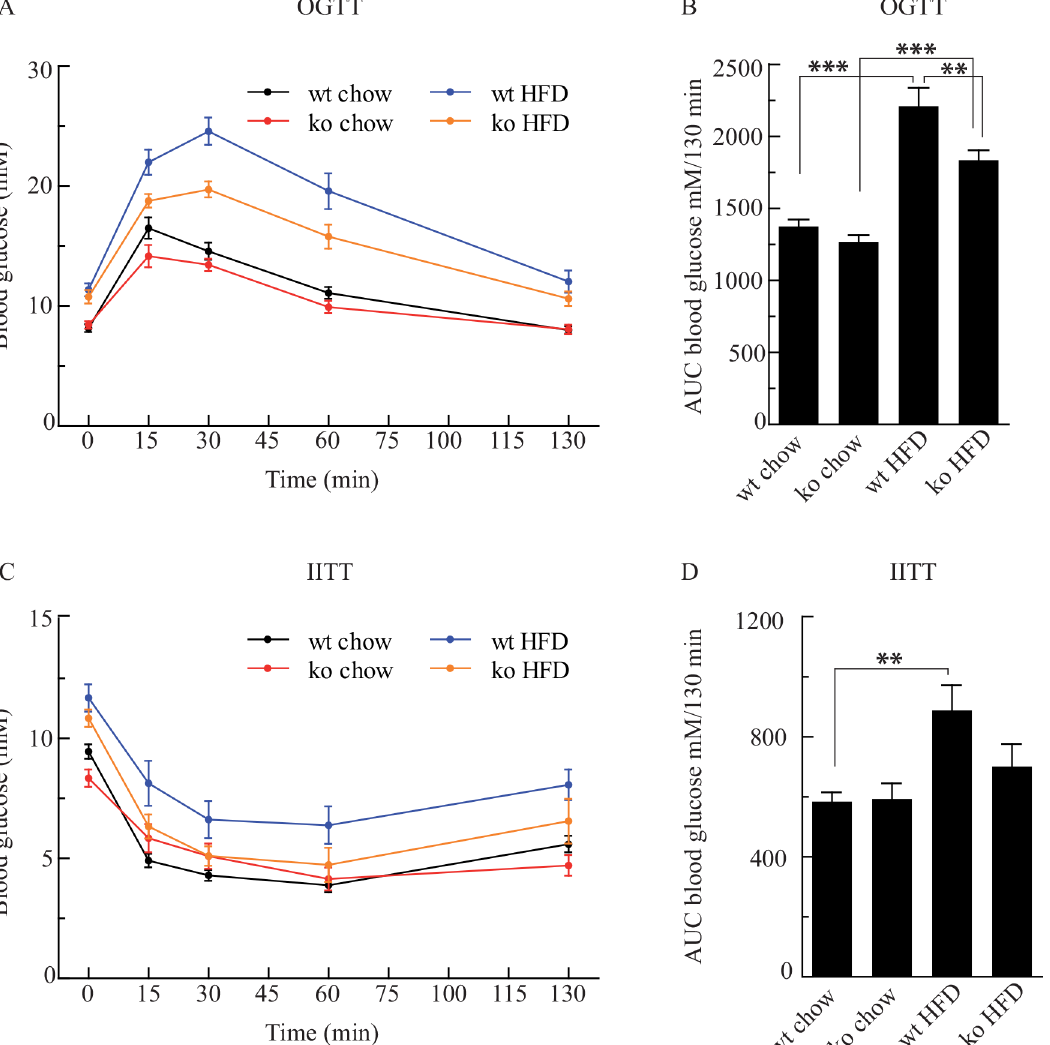
Fig 1. Cyp8b1 -/- (ko) mice show improved glucose tolerance and response to insulin on a high fat diet (HFD) as compared to Cyp8b1 +/+ (wt) mice. Blood glucose levels in response to oral glucose tolerance test (OGTT) (A) and area under the curves (AUCs) (B) . Blood glucose levels in response to intraperitoneal insulin tolerance test (IITT) (C), and as AUCs (D) . Data is shown as mean ± SEM, n = 16 for all groups. *** = p < 0.001 and ** = p <